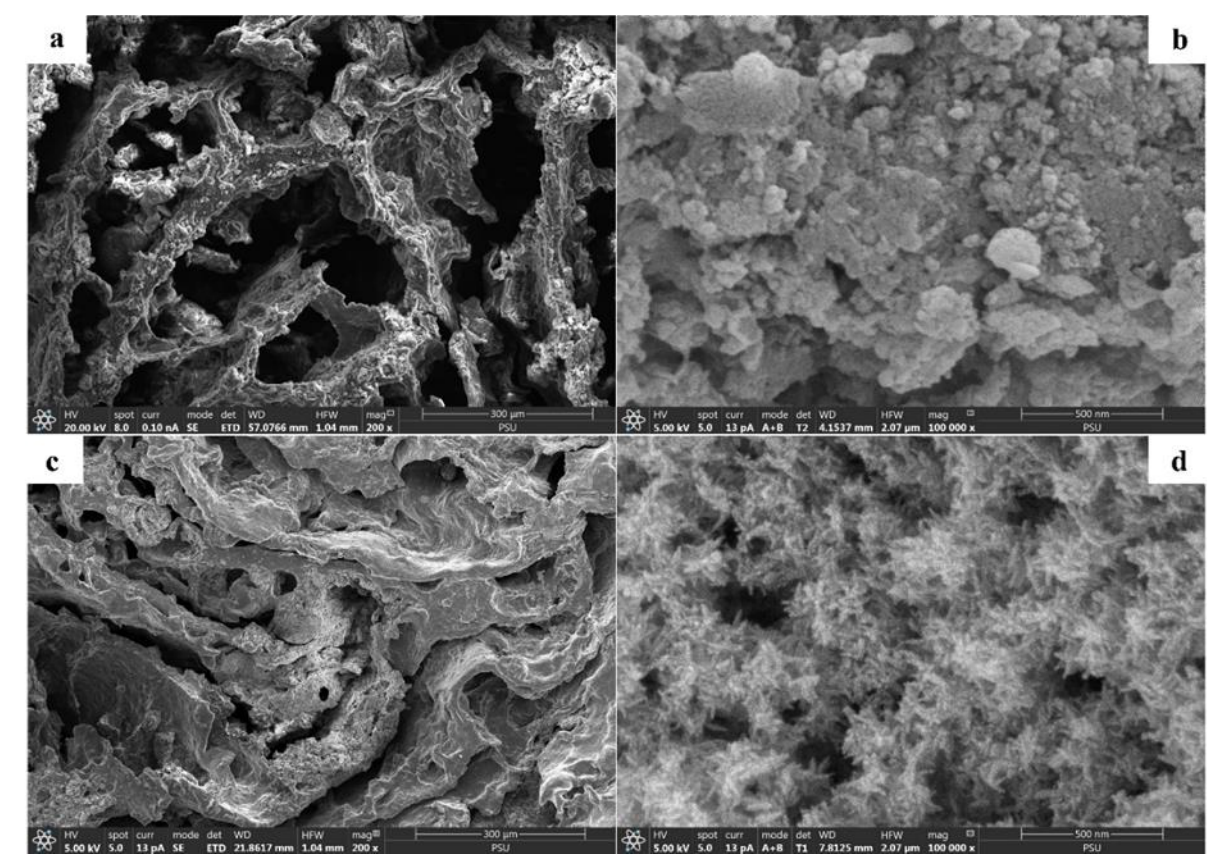
Figure 2. SEM images of Cry – CSH before ( a , b ) and ( c , d ) after adsorption of phosphate with magnification of 200 ( a , c ), and 100,000× ( c , d ).